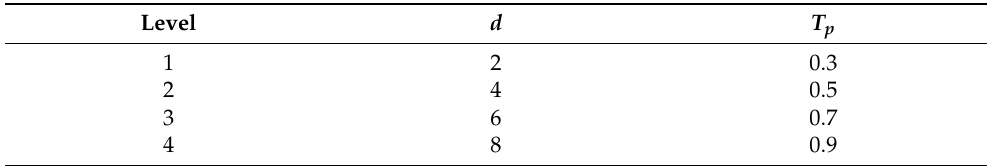
Table 3. Factor level of IG h